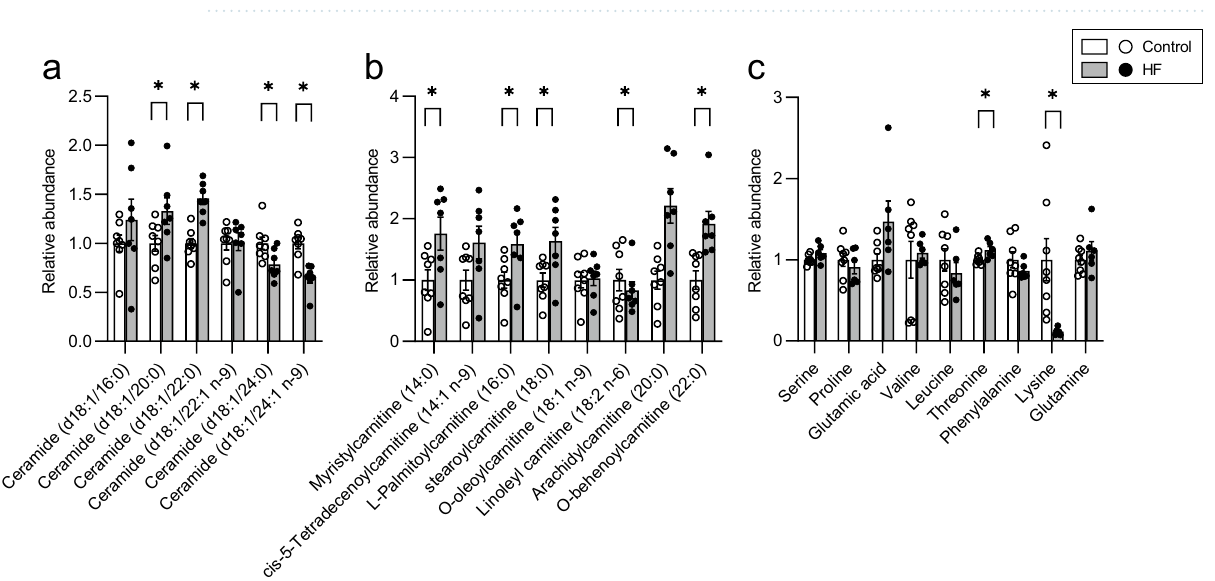
Figure 3. Correlation between the ratio of 12α BA/non-12 BA and hepatic TG concentration. Correlation in the liver, small intestine contents, feces, aortic plasma, and portal plasma. Filled bars represent HF (n = 8). P -values are shown in the inset.